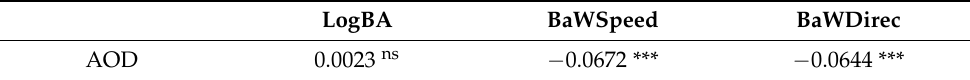
Table 3. Correlation between the instrumental variables and the explanatory variable. LogBA BaWSpeed BaWDirec AOD 0.0023 ns